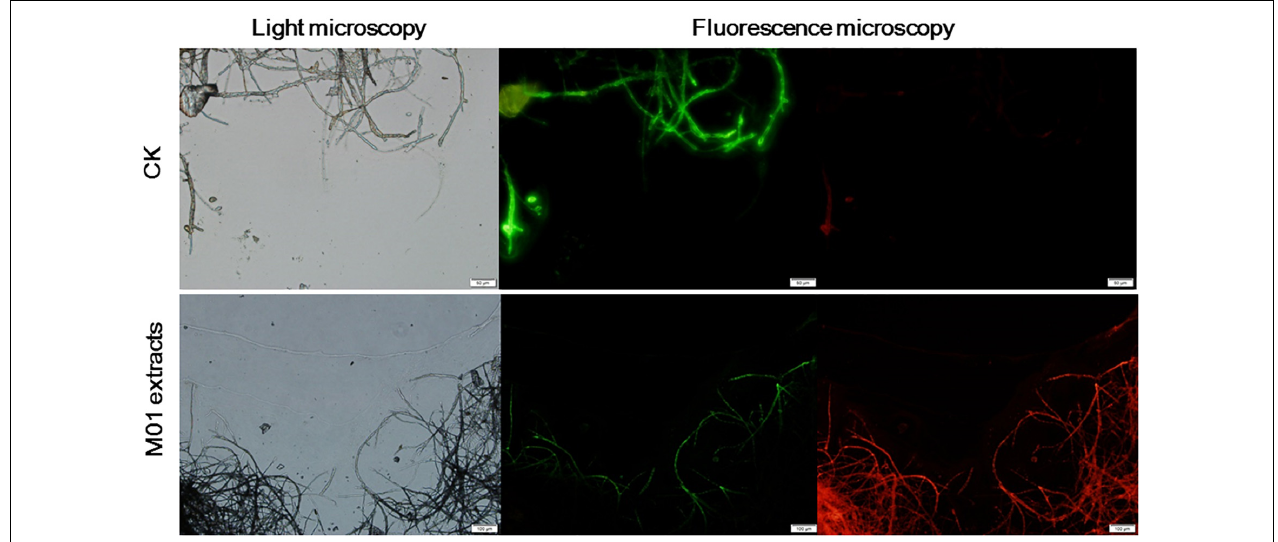
FIGURE 3 | Detection of A. alternata viability based on fluorescein diacetate and propidium iodide staining after treatment with S. lydicus M01 extracts for 12 h.